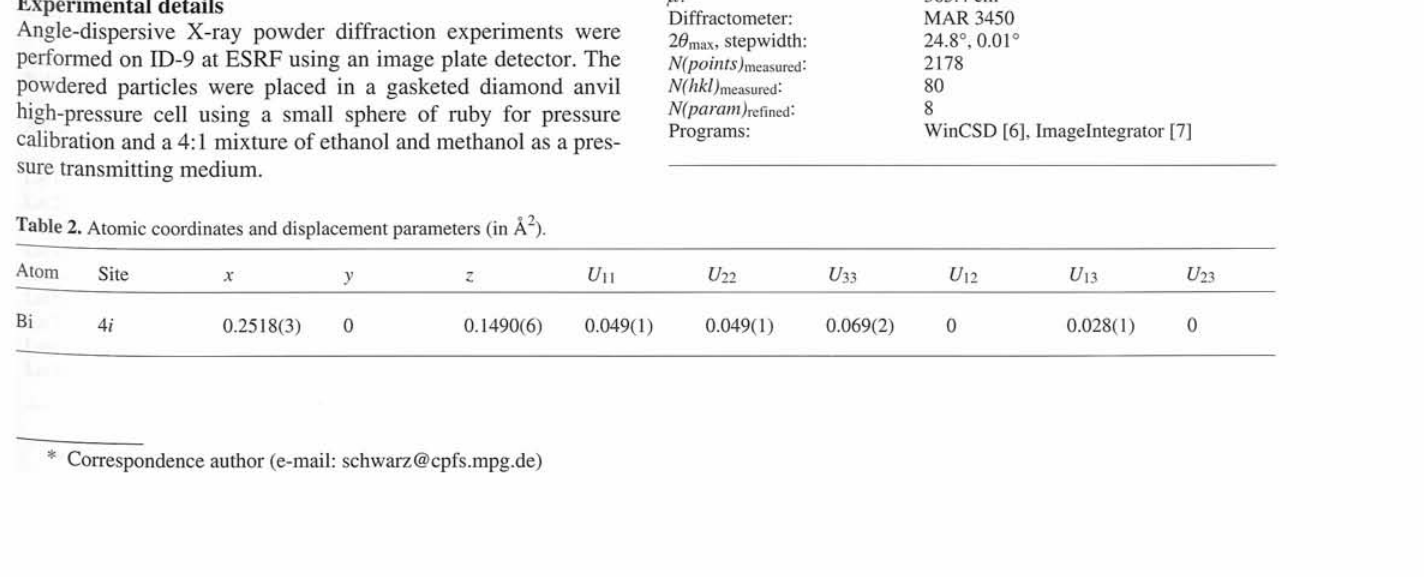
Table 2. Atomic coordinates and displacement parameters (in A").